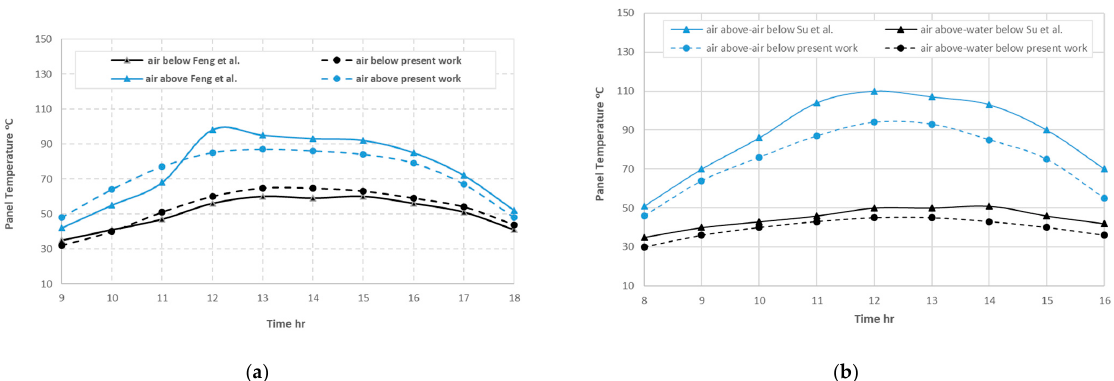
Figure 9. Hourly variations in panel temperature ( a ) for present model and [43] ( b ) for present model and [44].